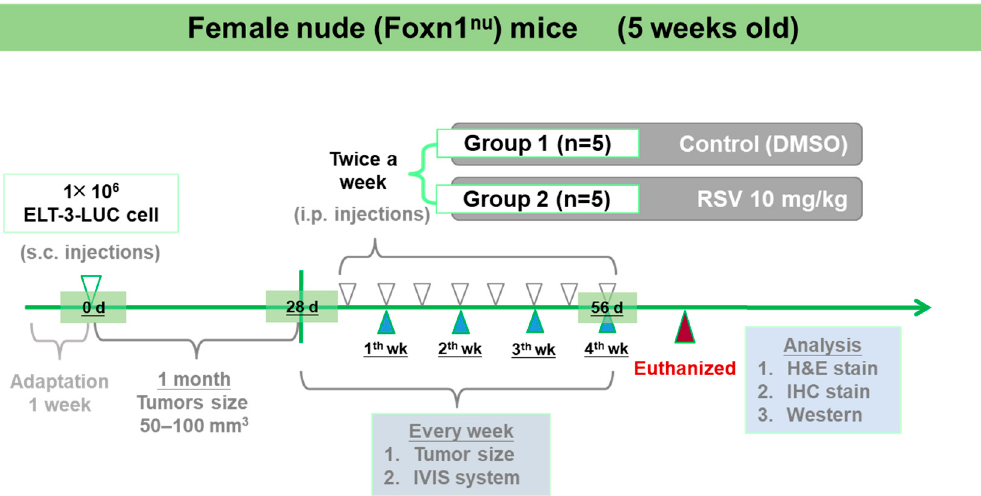
Figure 1. Schematic representation of the treatment plan for the xenograft mouse model. Cultured Eker rat-derived uterine leiomyoma cells transfected with luciferase (ELT-3-LUC) embedded in Dulbecco’s Modified Eagle Medium / Nutrient Mixture F-12 (DMEM / F12) / Matrigel solution were transplanted into the right flank of female nude (Foxn1 nu ) mice. When the tumors reached a size of 50–100 mm 3 (approximately 1 month), the mice received an intraperitoneal injection of either resveratrol (RSV; 10 mg · kg − 1 ) or vehicle control (dimethyl sulfoxide; DMSO) twice a week for 1 month. nude (Foxn1 nu ) mice: nude mice with a spontaneous deletion in the FOXN1 gene; IVIS: non-invasive in vivo imaging system; H&E: hematoxylin and eosin; IHC: immunohistochemical.